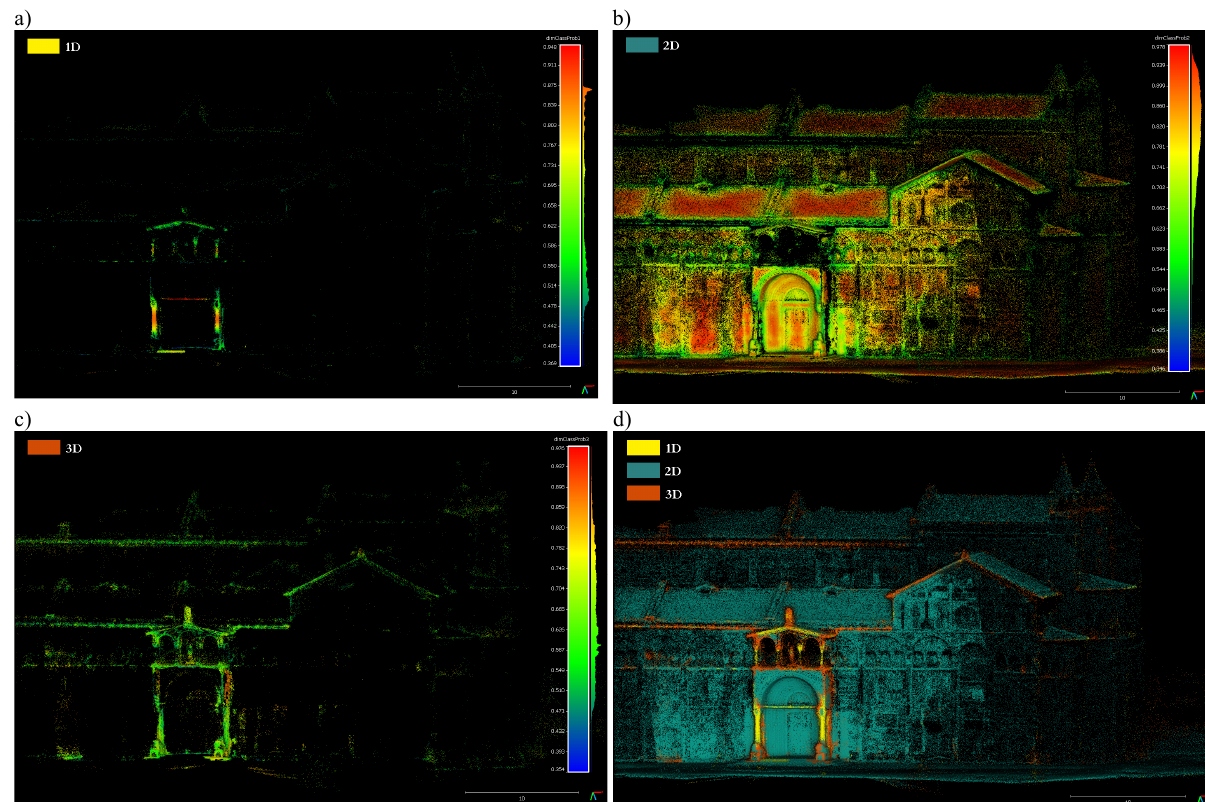
Figure 5: Dimensionality probabilities of each point to belong to 1D (a), 2D (b) or 3D (c) class and the overall visualization of the computed final labelled classes